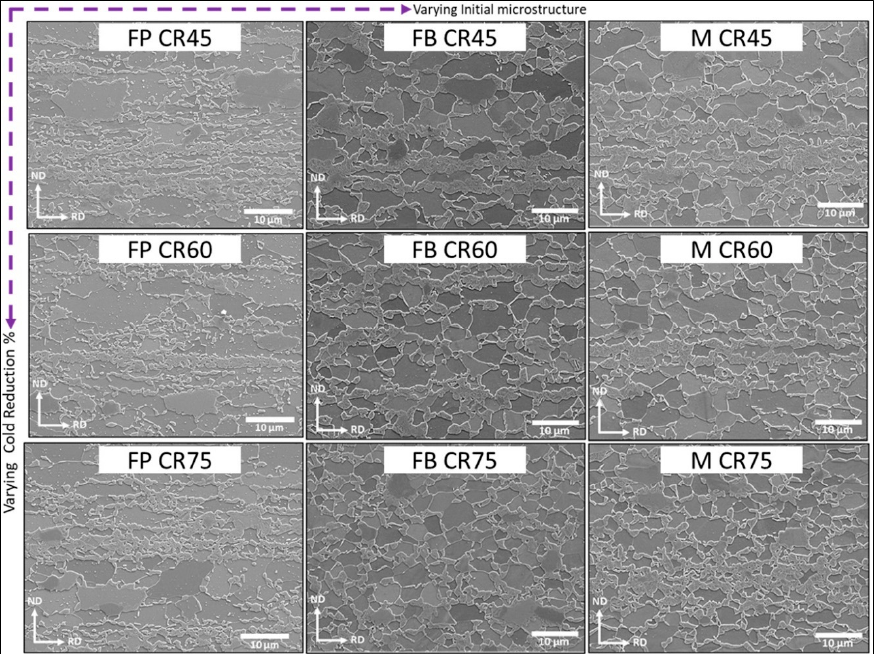
Figure 8. SEM micrographs of cold rolled Ferrite–Pearlite (FP), Ferrite–50% Bainite (FB) and fully Martensite/Bainite (M) steel samples annealed using a peak temperature of 730 °C (FP and FB) and 750 °C (M), respectively. Table 3. Comparison of the ferrite grain sizes and martensite volume fractions with respect to cold reductions and initial microstructures after inter-critical annealing.